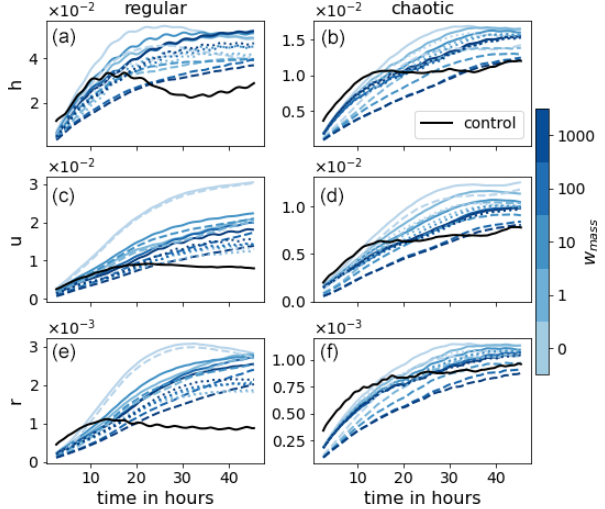
Figure 12. Evolution of SD total , SD time , and SD ANN (solid, dotted, and dashed lines, respectively) for the different weightings (blue colors) for the regular (a, c, e) and the chaotic (b, d, f) cases.